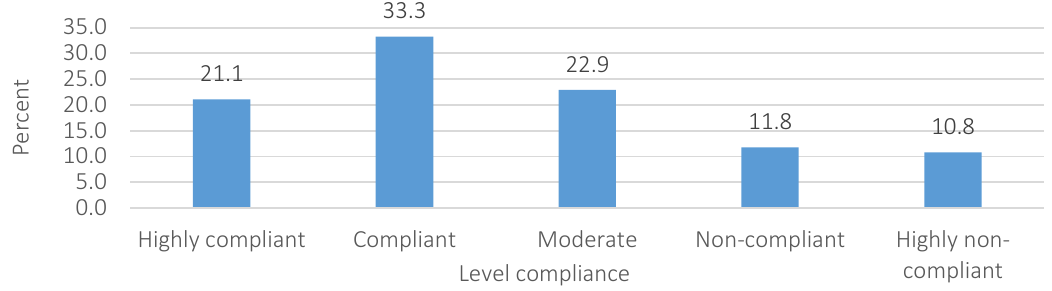
Figure 1. The perceived level of tax